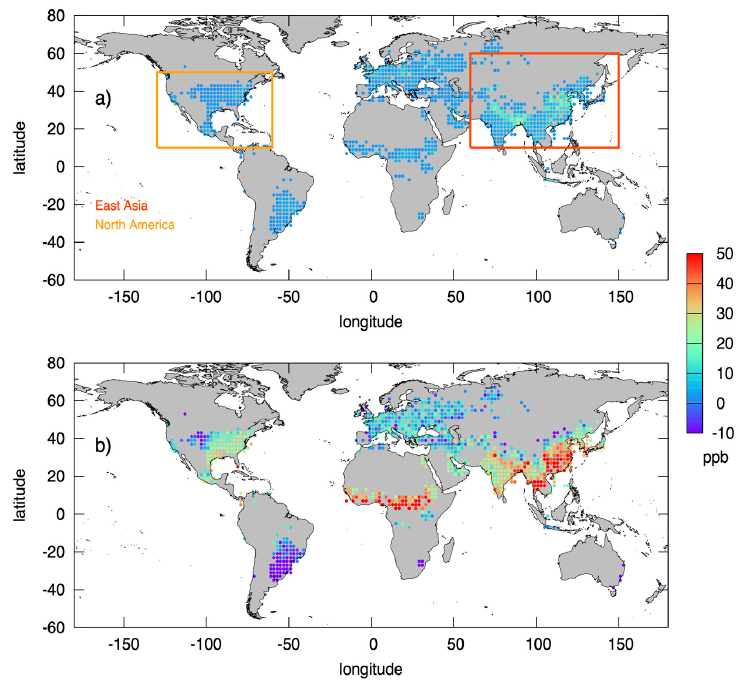
Figure 1. The simulated ( a ); and GOSAT observed ( b ) XCH 4 anomaly (ppb) ( Δ XCH 4,sim and Δ XCH 4 , obs , respectively) aggregated at 2° grid for a period 2009–2012. The grids with simulated XCH 4 abundance greater than 5 ppb in average are shown. The regions used in analysis are marked as rectangles in upper panel.